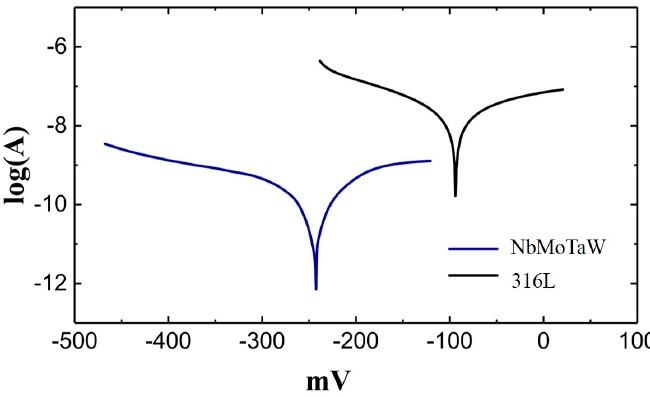
Figure 8. Polarization curve patterns of WMoNbTa HEA and 316 L.